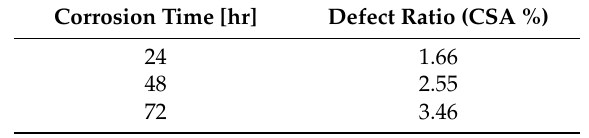
Figure 8. Pipe surface after corrosion ( left ) and diagram of cross-sectional area loss ( right ).